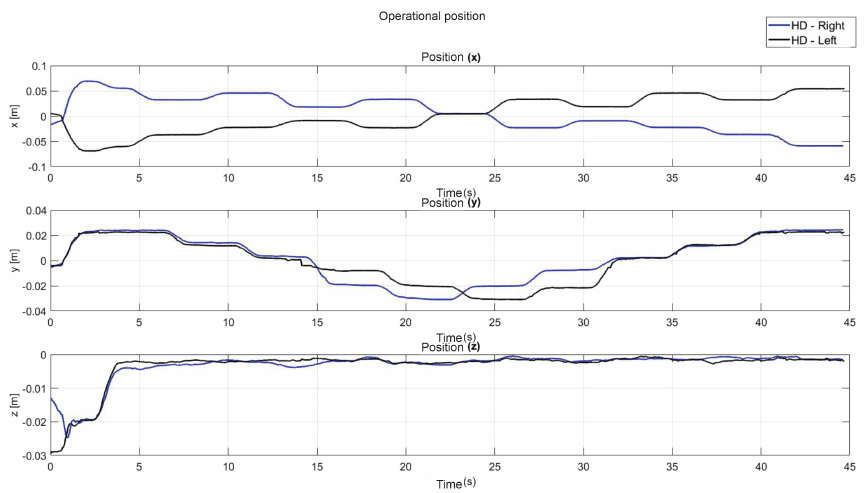
Figure 28. Operational position of two haptic devices in passive haptic guidance task: exercise